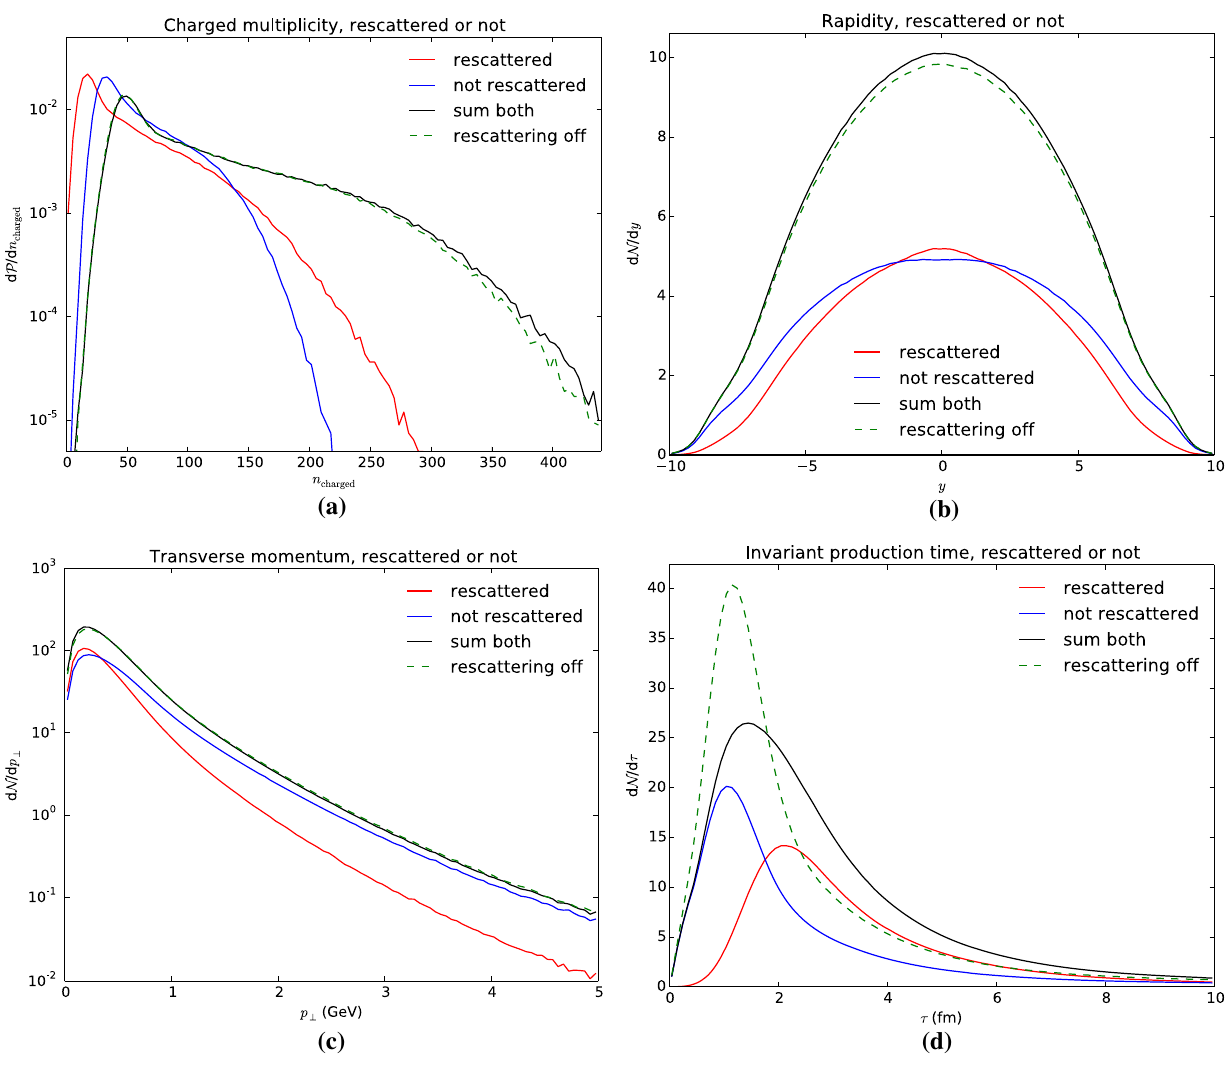
Fig. 8 a Multiplicity, b rapidity, c transverse momentum, and d invari- ant production time spectra of charged final-state hadrons, subdivided into those that have been involved in rescatterings and those that have